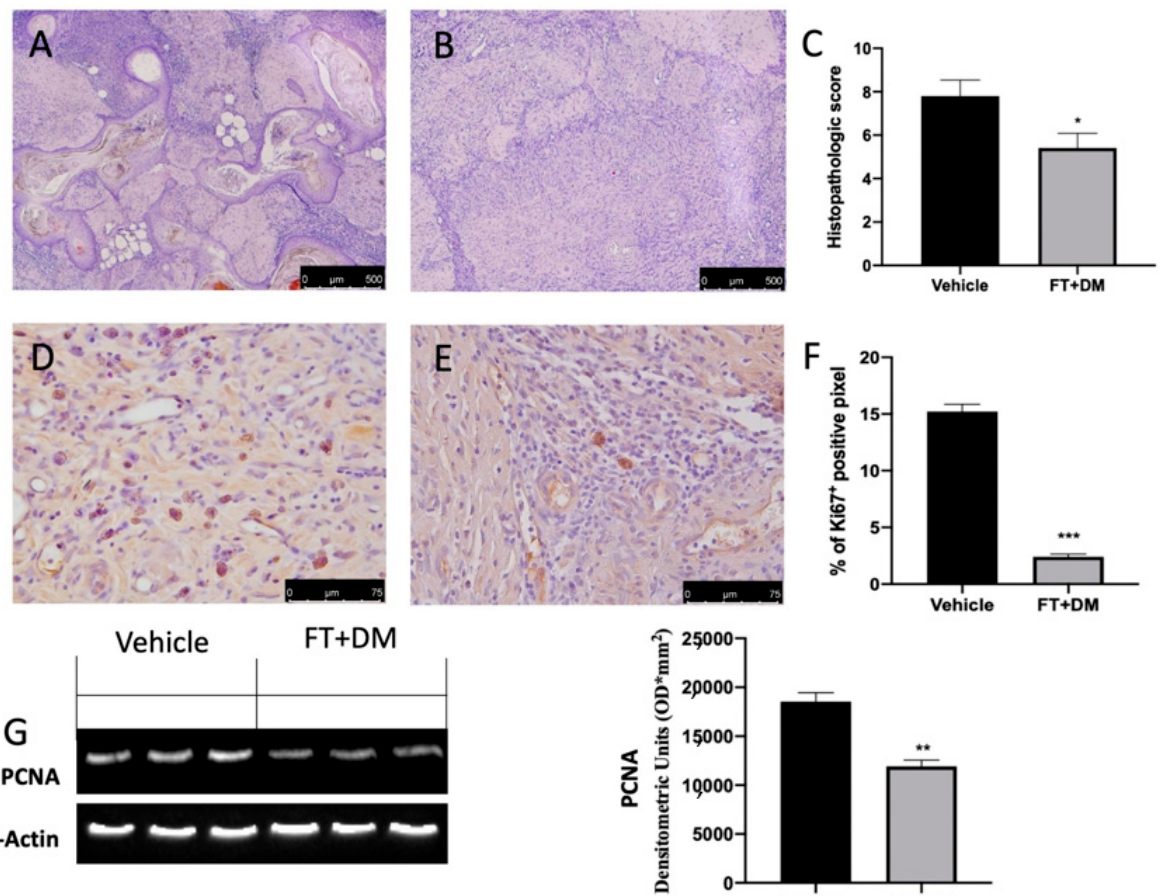
Figure 3. FT+DM administration reduced histological score, hyperproliferation and apoptosis. Histological analysis: vehicle ( A ); FT+DM ( B ). Histological score ( C ). Immunohistochemical analysis of Ki67: vehicle ( D ); FT+DM ( E ). Graphical quantification of KI67 expression ( F ). Western blot analysis of PCNA ( G ). A p -value of less than 0.05 was considered significant: * p < 0.05, ** p < 0.01 vs. vehicle, *** p < 0.001 vs. vehicle.